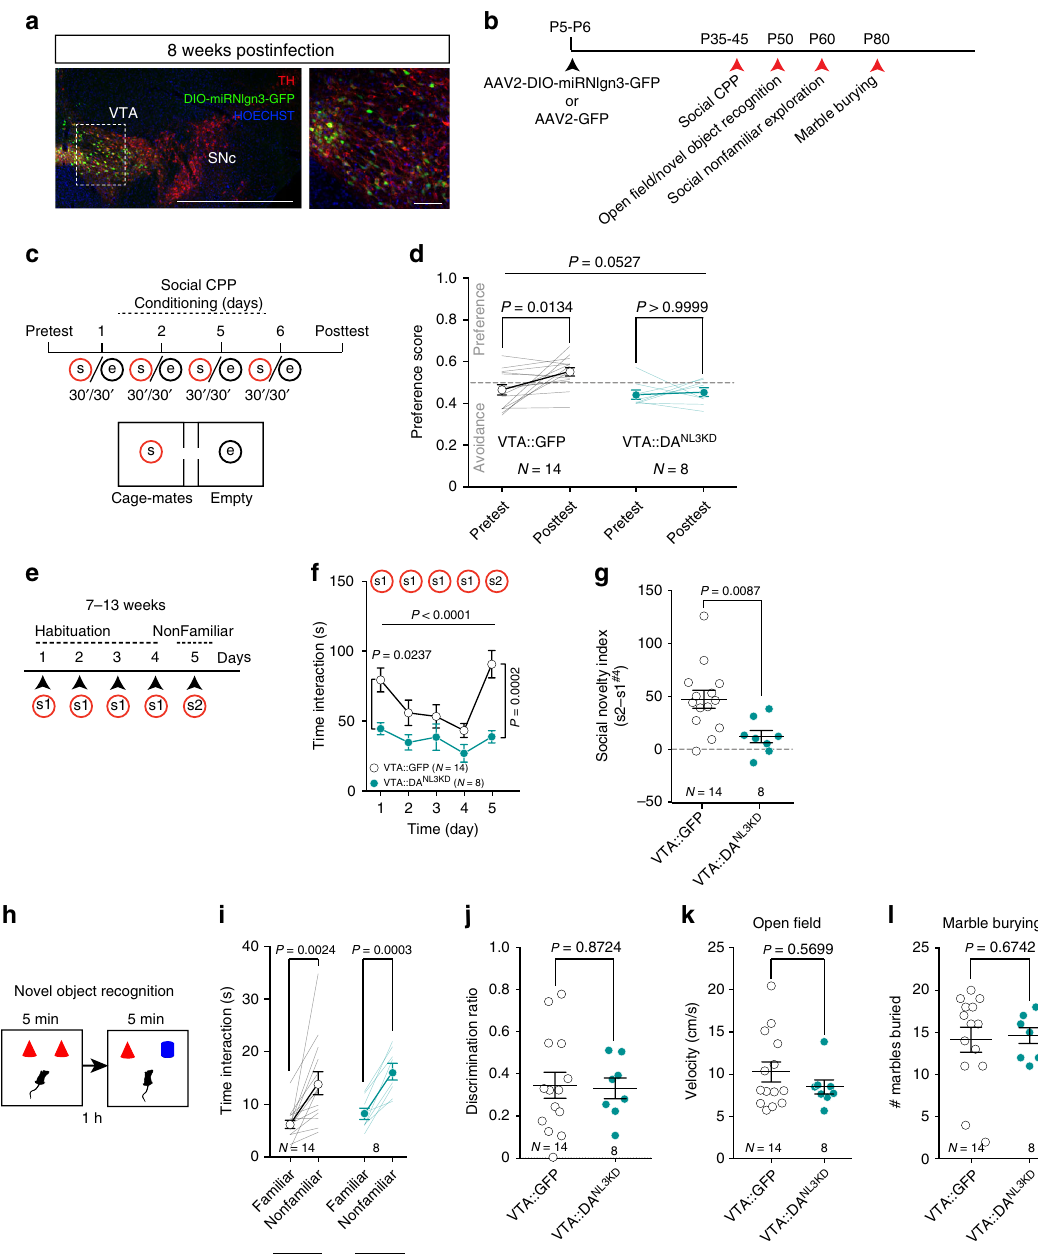
8)VTA::GFP ( N = 14) VTA::DA NL3KD ( N =